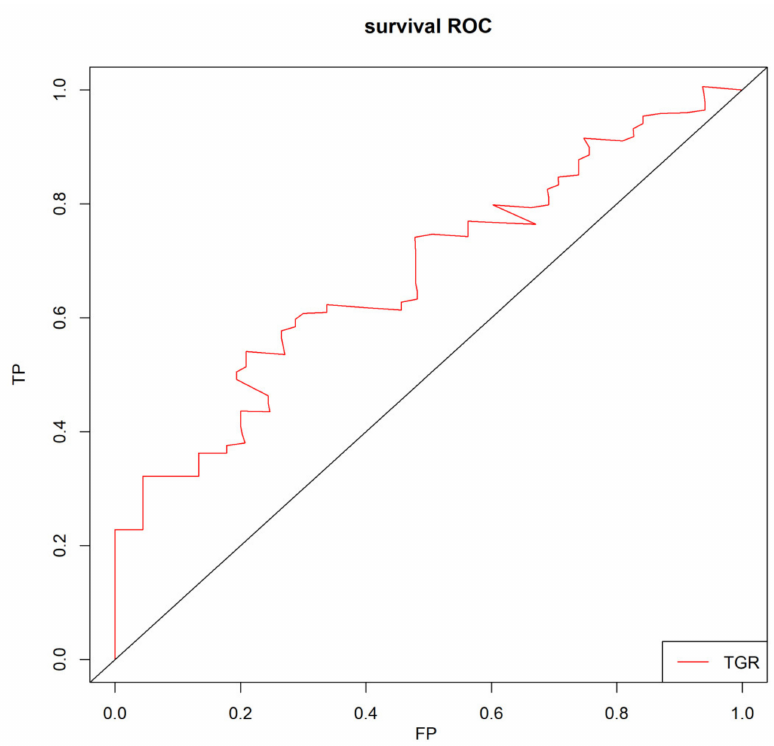
Figure 2. Time-dependent receiver operating characteristic curve (timeROC) for TGR in HHCC patients.